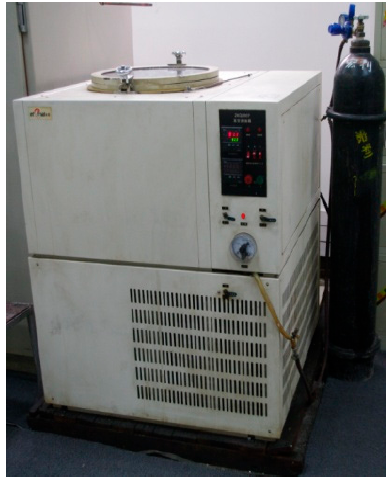
Figure 2. Vacuum oil impregnation tank.